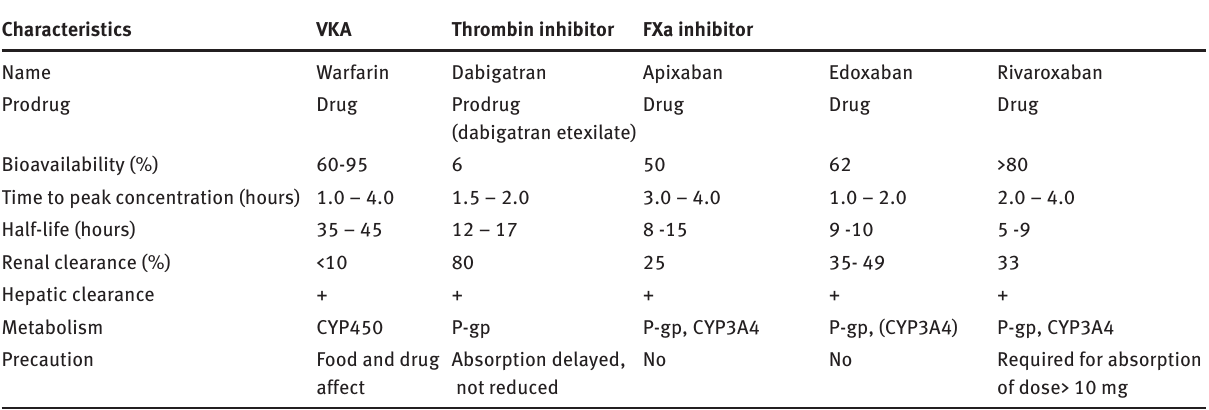
Table 1: Pharmacological characteristics of the vitamin K antagonist and the direct oral anticoagulants [2,24,30]